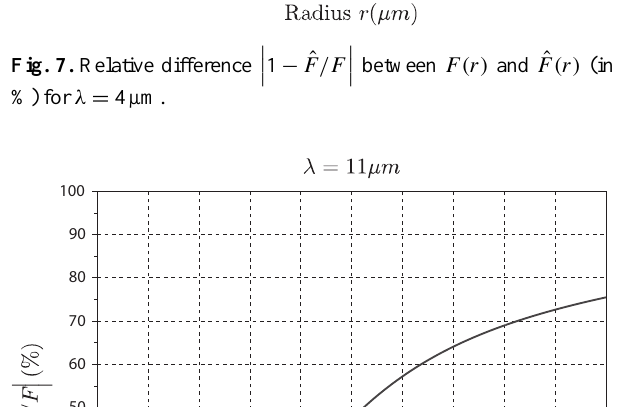
(cid:12) (cid:12) (cid:12) (cid:12) − ˆ F/F (cid:12) 1 (cid:12) between